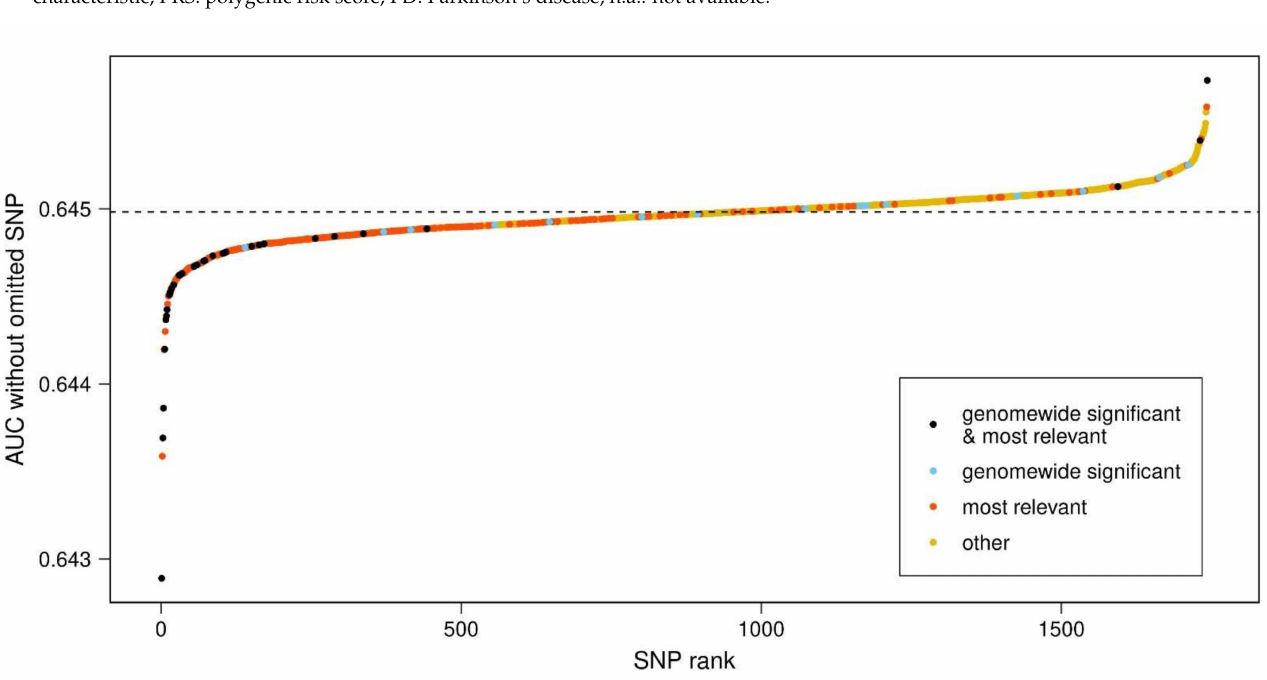
Figure 4. Influence of individual SNPs upon PD-PRS performance. For each of the 1743 PD-PRS SNPs, the AUC was calculated after removing the SNP from the PRS. SNPs were color-coded as either genome-wide significant in a meta- GWAS [2] (blue), as ‘most relevant’ in the present study (red), both of the former (black) or none of the former (yellow). SNP: single nucleotide polymorphism, PD: Parkinson’s disease, PRS: polygenic risk score, AUC: area under ROC curve, ROC: receiver operating characteristic, GWAS: genome-wide association